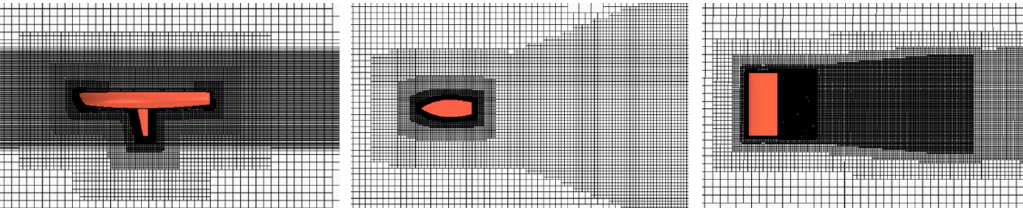
Figure 11. Mesh settings